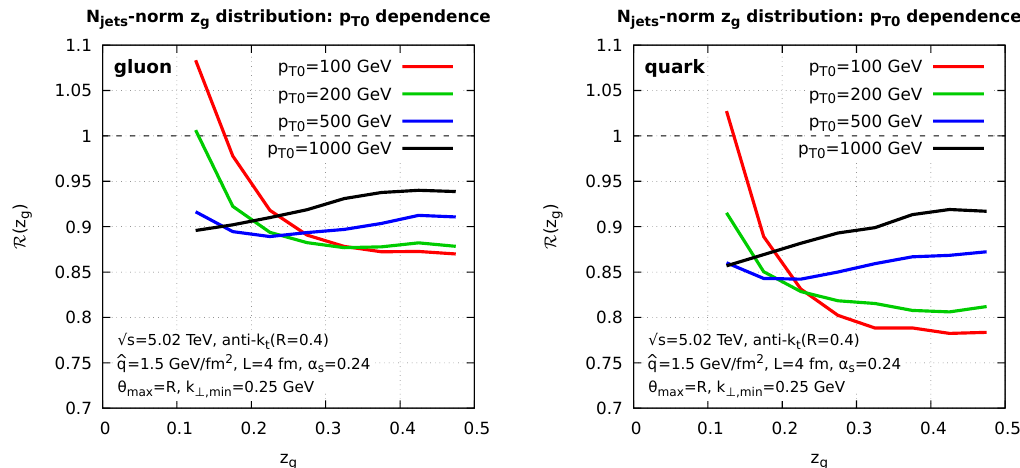
Figure 8 . A summary of our MC results for the medium/vacuum ratio R i ( z g ) of the N jets - normalised distributions, for monochromatic jets initiated either by a gluon (left (cid:12)gure), or by a quark (right (cid:12)gure), and for 4 di(cid:11)erent values for the initial transverse momentum p T 0